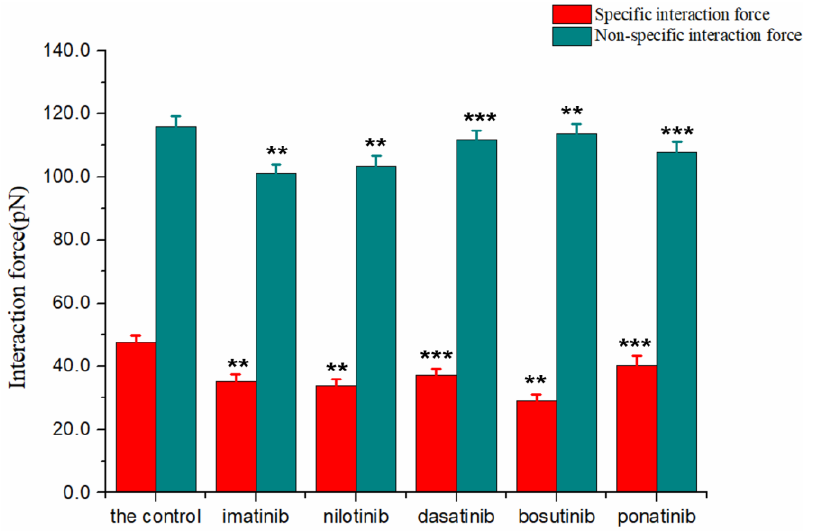
Figure 4. The specific/non-specific interaction forces between HSA pairs in the control and TKIs are summarized using a bar graph. All experiments were performed 300 times ( n = 300). *** p < 0.001, ** p < 0.005 vs. the control.